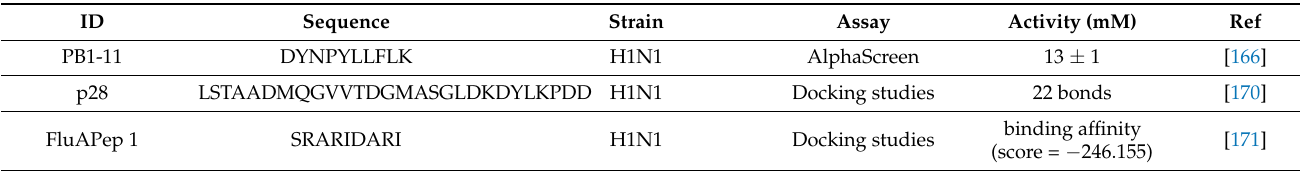
Table 5. Most representative peptides targeting